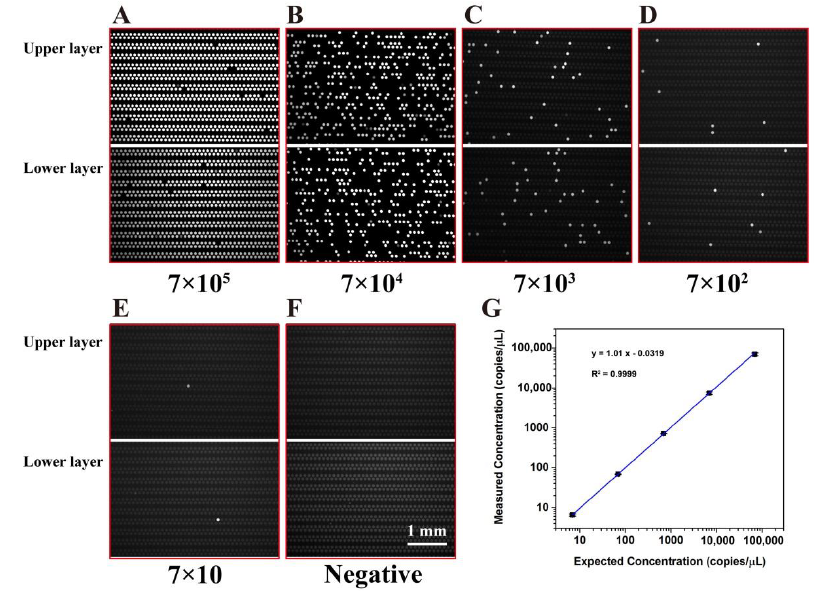
Figure 6. Digital PCR on the microfluidic dPCR chip with different concentrations of KRAS DNA: ( A – E ) Digital PCR on the dPCR chip with a serial dilution of target DNA template ranging from 7 × 10 5 to 7 × 10 copies/μL. ( F ) The negative assay was in control when no target template was loaded. ( G ) The linear relationship between the measured concentration in the dPCR chip and the expected DNA concentration.